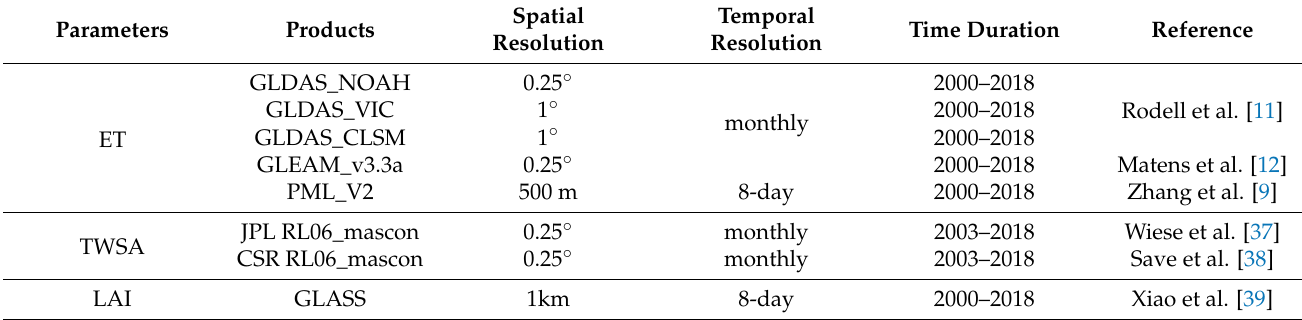
Table 1. Global products used in this study.